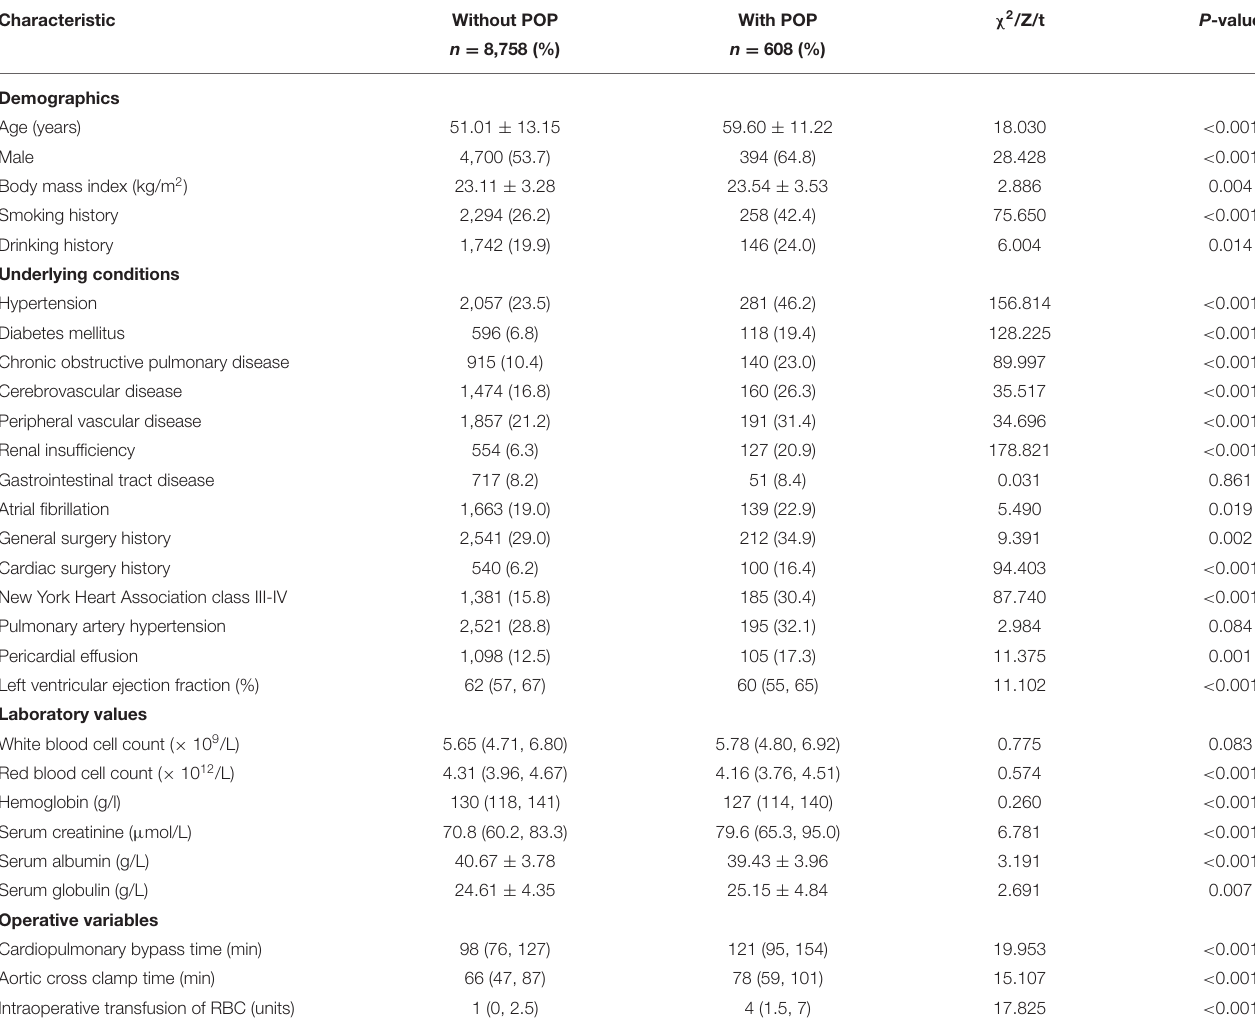
TABLE 2 | Univariate analysis of possible risk factors for POP after elective cardiac surgery in the training set. Characteristic Without POP With POP χ 2 /Z/t